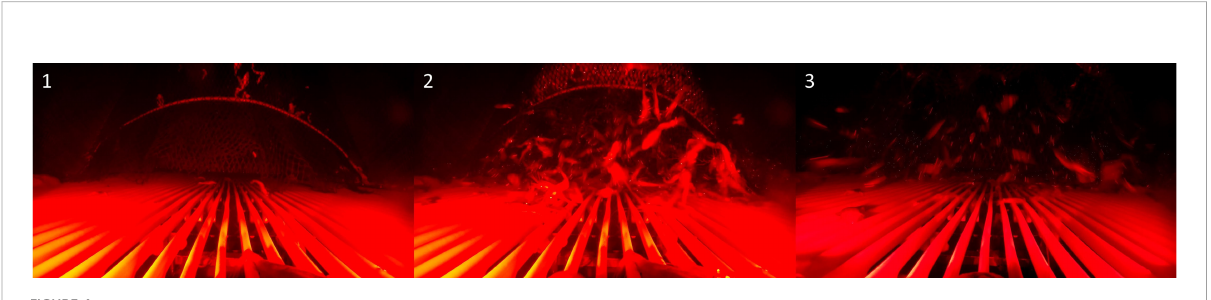
FIGURE 4 Underwater video screenshots of the 19-mm bar spacing Nordmøre grid during fi shing. (1) The guiding panel exit opening on its starting position at the beginning of the tow. (2) Two minutes has elapsed since shrimp and fi sh reached the grid section, where shrimp and fi sh are seen meshed in the guiding panel netting. (3) The guiding panel exit has fully opened and remained in this position until the end of the